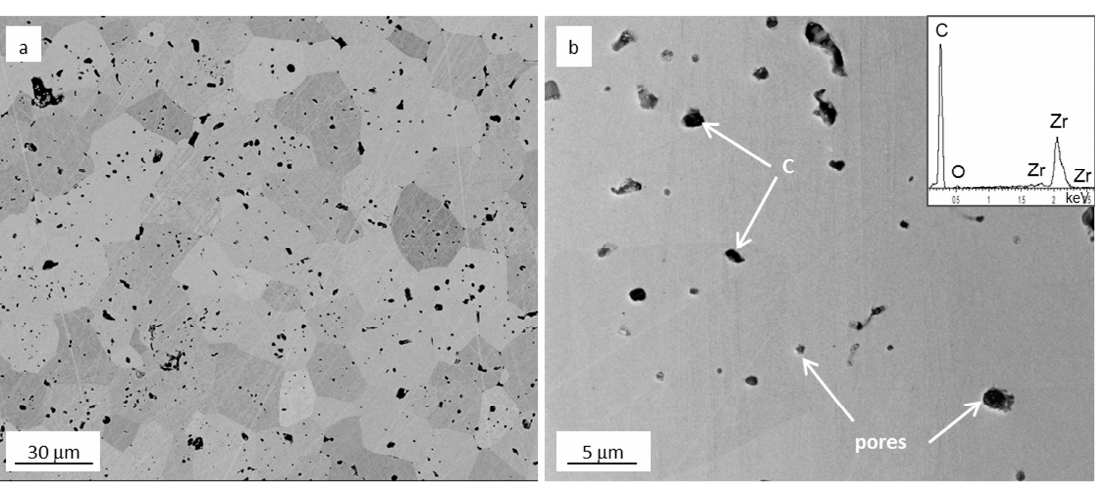
Figure 6. SEM images of the polished surface of the SHS-SPSed ZrC sample showing ( a ) a microstructure overview in back-scattered image mode and ( b ) the presence of closed porosity and carbon inclusions in In-lens mode with the EDS spectrum of C-rich pockets inset.